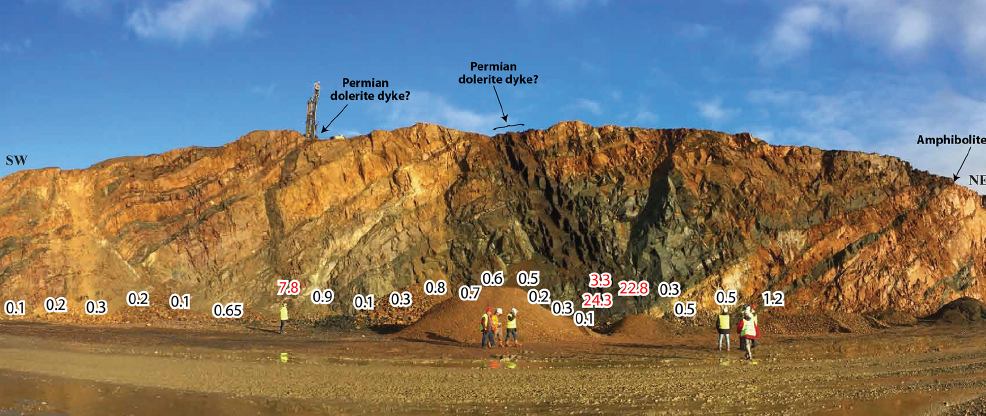
Figure 15. Magnetic susceptibility measurements (average of three to five readings at each point is shown) across a section of the rock quarry north of the study area showing how strongly magnetic (orders of 3–25 higher) the Permian dolerite dykes are compared to the other country rocks (e.g., amphibolite and gneiss) in the area. The main dyke observed here has a NE dip component similar to those observed in the reflection seismic data. Magnetic susceptibilities are shown as 10 − 3 SI units (e.g., 22.8 becomes 0.0228 in the SI unit). An SM20 handheld susceptibility meter was used for these